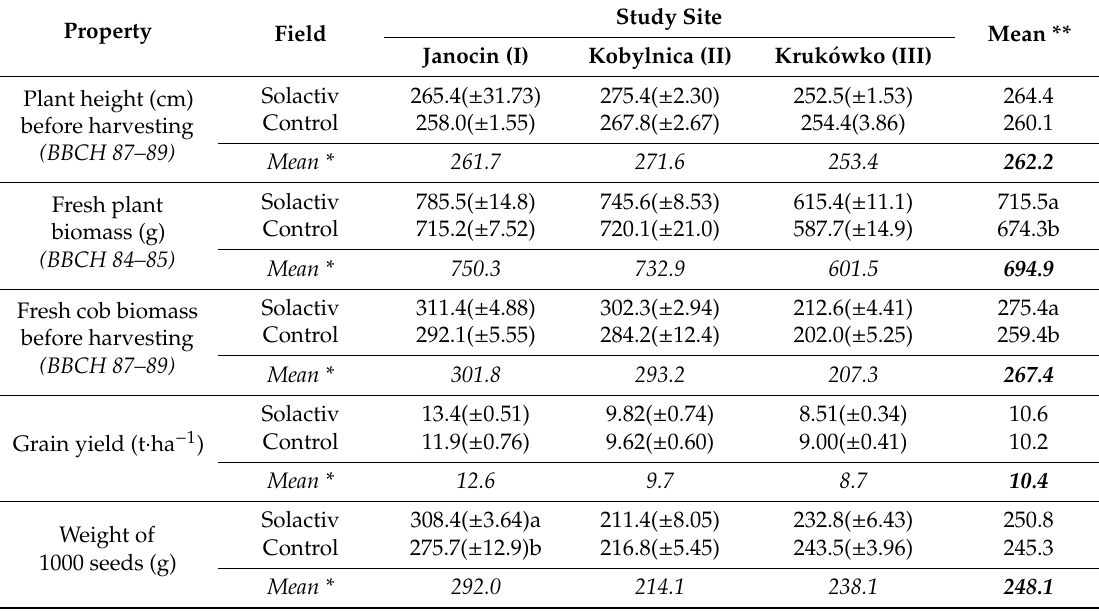
Table 5. Maize-related properties at the three study sites as a ff ected by the applied conditioner (mean ±